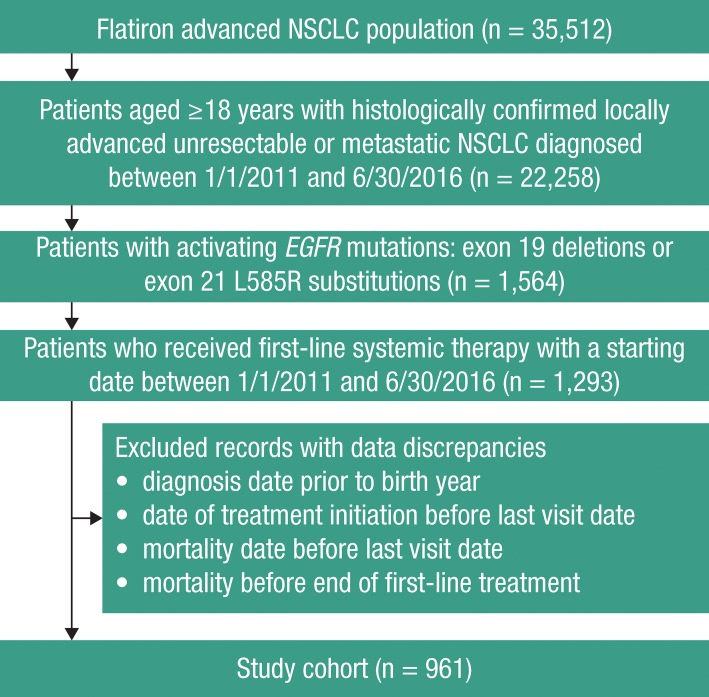
Participant flow through the study.